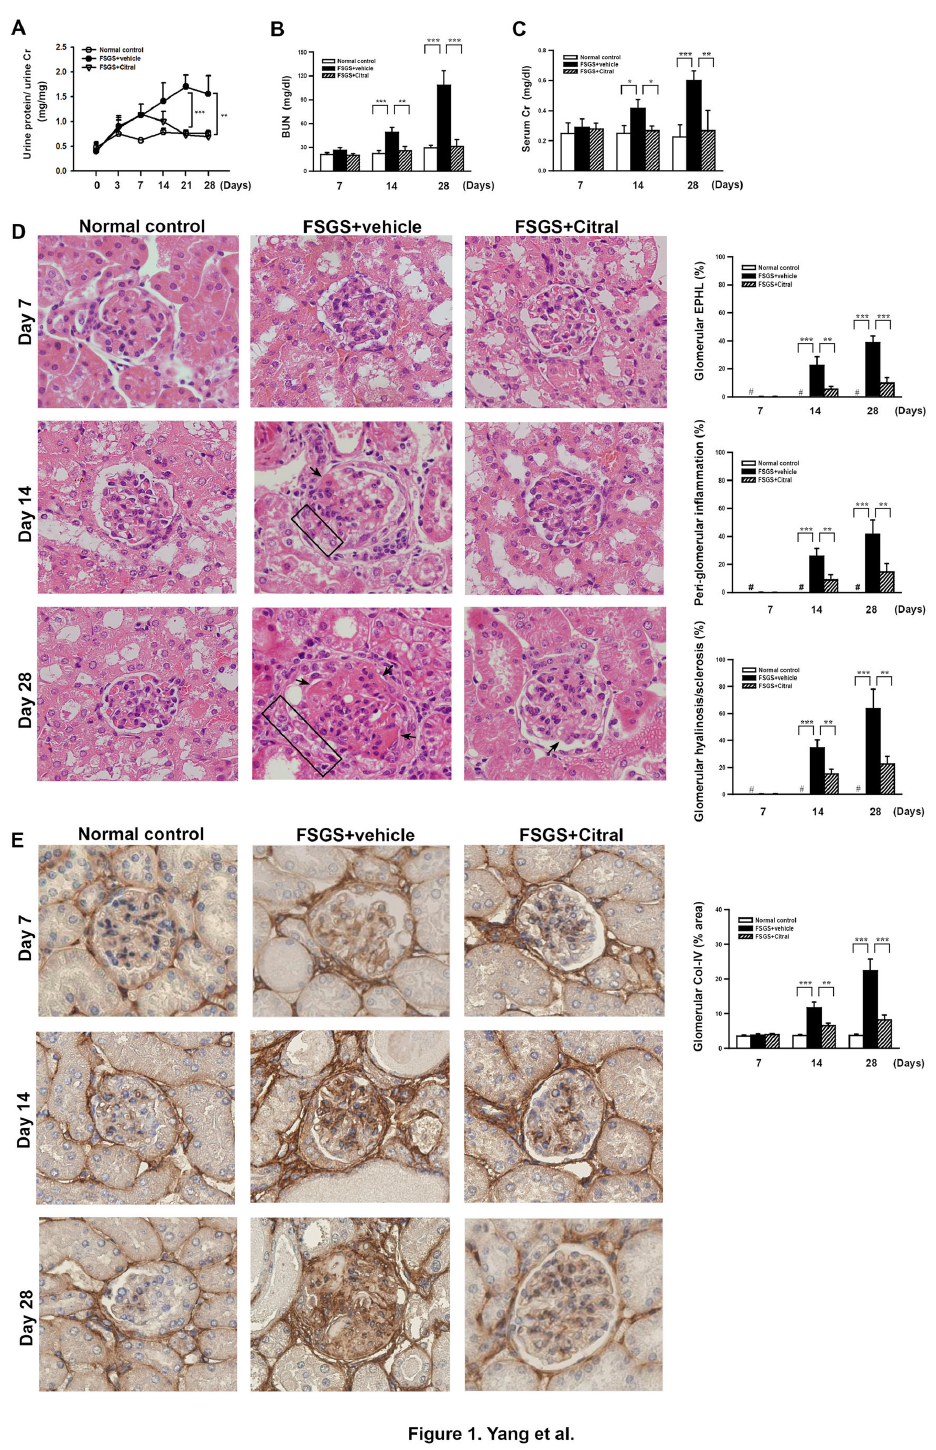
Figure 1. Urine protein, renal function, renal histopathology, and hyalinosis/sclerosis. (A) Urine protein time-course study. (B) Serum BUN levels on days 7, 14, and 28. (C) Serum creatinine levels on days 7, 14, and 28. (D) Kidney histopathological evaluation by H&E staining on days 7, 14, and 28. The arrows indicate hyalinosis/sclerosis, and the rectangles EPHLs. (E) Immunohistochemical staining for renal Col-IV. In D and E, the original magnification was 400× and the scoring is shown on the right. In the histograms, the data are the mean±SEM for seven mice per group. * p < 0.05, ** p < 0.01, *** p < 0.005. #, not detectable. doi: 10.1371/journal.pone.0074871.g001 PLOS ONE |